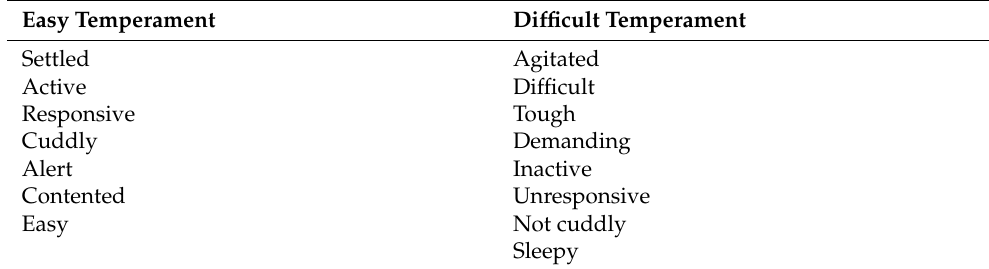
Table A1. Adjectives for each category of the ePrime questionnaire on infant